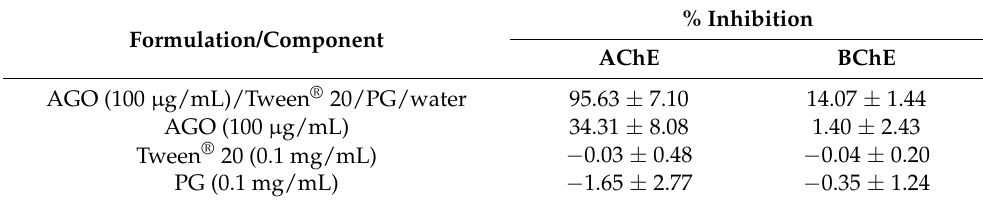
Table 4. Anticholinesterase activities of microemulsion formulation and each component. Formulation/Component